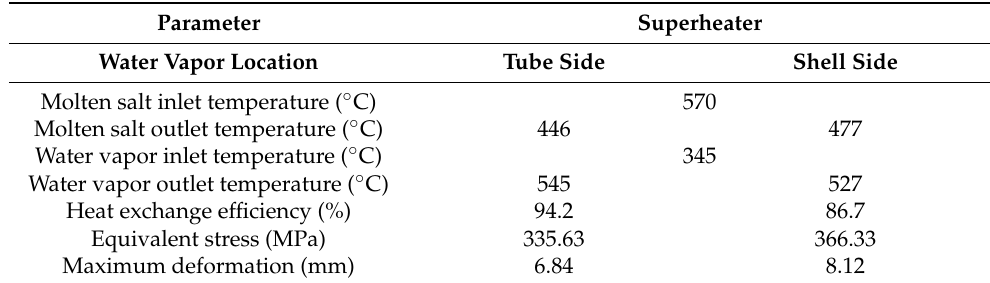
Table 4. Summary of inlet and outlet and stress distribution field parameters on the tube side and shell side of the heat exchanger.